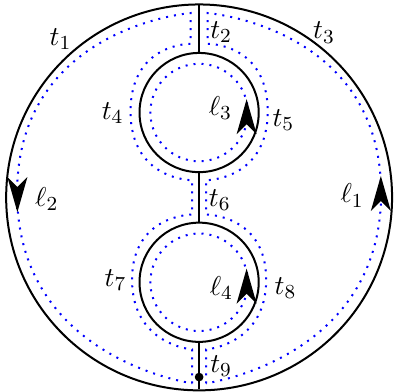
Figure 29. A 4-loop graph with a homology basis marked. This example shows the necessity of including contributions from non-identity Schottky group elements in the period matrix formula eq. (3.11) even at leading